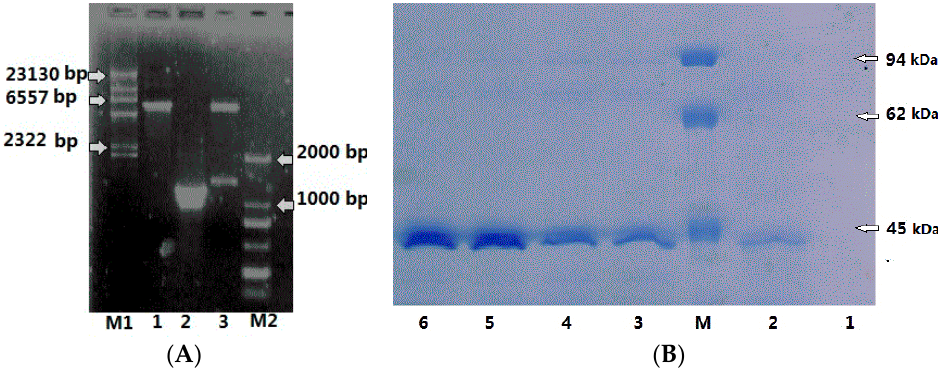
Figure 4. ( A ) Identification of plasmids constructed in this study ( M1 : λ DNA/ Hind III marker; M2 : DL 2000 marker; Lane 1 : pET28a vector; Lane 2 : PCR amplicon; Lane 3 : Recombinant plasmid);